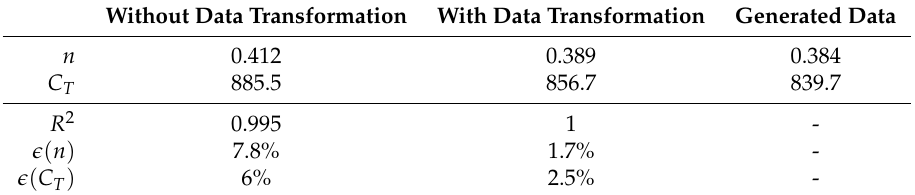
Table 2. Least squares estimated values, coefficient, and relative error ( (cid:101) ) on the Taylor parameters from the MUT predictions with and without data transformation, compared to the learning set values. Without Data Transformation With Data Transformation Generated